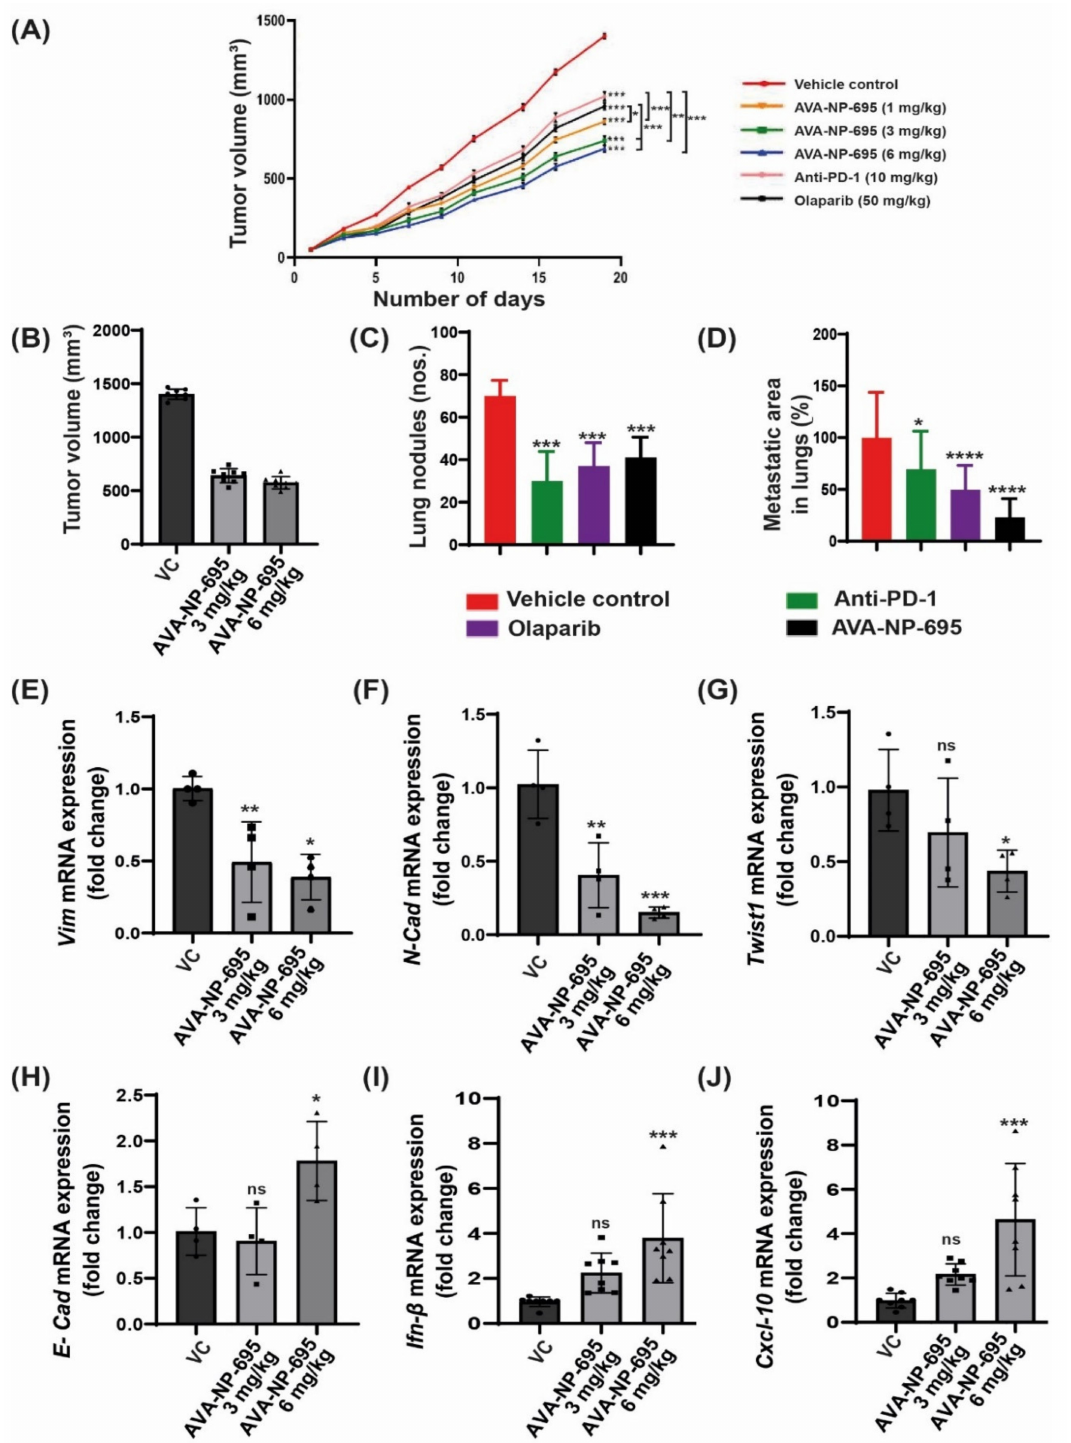
Figure 6. AVA-NP-695 demonstrates superior anti-tumor efficacy and reduces metastasis in the 4T1 syngeneic model. ( A ) Tumor volume at given time points was measured with different concentra- tions of AVA-NP-695 (1 mg/kg, 3 mg/kg, 6 mg/kg) and anti-PD1 and Olaparib and the growth kinetics of the mice after treatment (n = 8). All the animals were sacrificed on day 19. ( B ) Tumor volume at day 19 was plotted for the vehicle and 2 dose of AVA-NP-695 (3 and 6 mg/kg) (n = 8). ( C ) The metastatic lung nodules by 4T1 cells were visually counted for each animal of the respective group indicated in the graph and the average number of nodules is presented as mean ± SD (n = 8) after sacrificing the animals on day 19. ( D ) Histological analysis of lung metastasis of 4T1 tumors